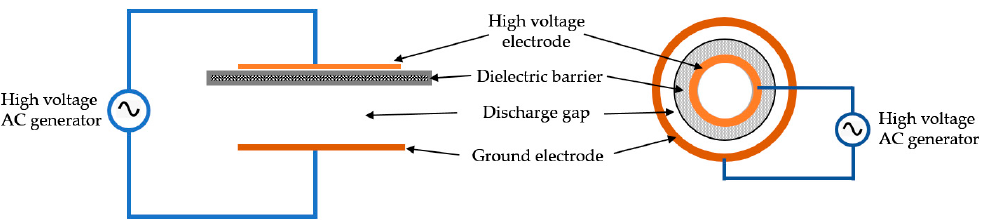
Figure 2. Parallel and concentric dielectric barrier discharge (DBD) configurations [91].